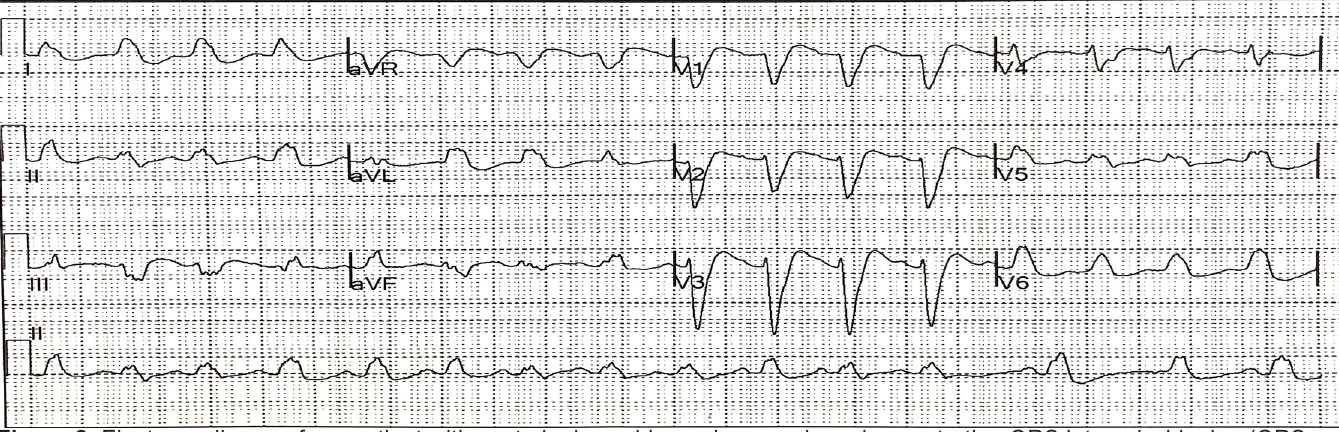
Figure 2. Electrocardiogram from patient with acute hydroxychloroquine overdose demonstrating QRS interval widening (QRS interval = 254